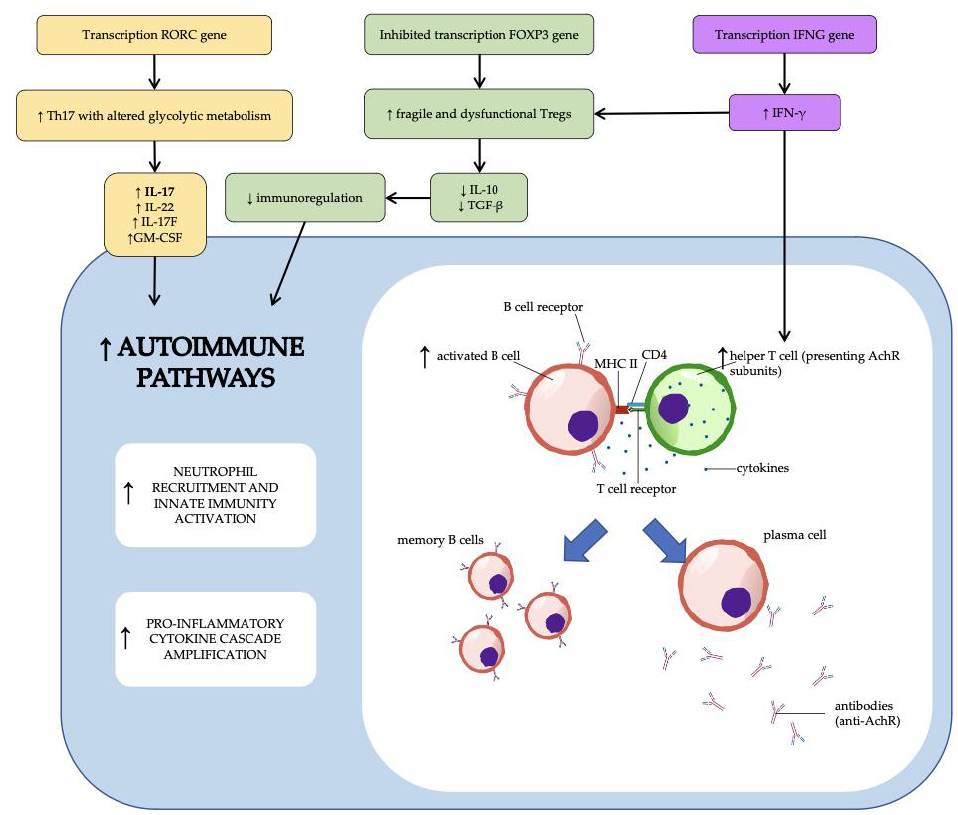
Figure 2. Immune system-related genes activated/inhibited by HIF- 1α transcriptional function in hematopoietic progenitors. RORC (RAR- related orphan receptor C) gene encodes for RORγt, FOXP3 (forkhead box protein 3) gene encodes for FoxP3, and IFNG gene encodes for INF- γ. The boost of HIF- 1α in blood progenitors of patients with VHL mutation also shifts the lymphocytic patrimony toward Th17 cells, with an altered glycolytic metabolism [64 –